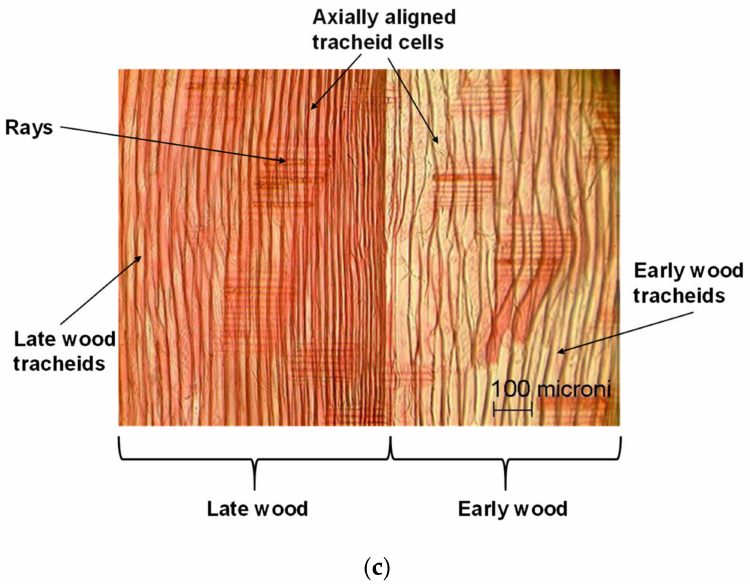
Figure 9. The microscopic view of Scots pine wood: ( a ) Cross section, magnification × 500; ( b ) longitudinal—tangential section, magnification × 100; ( c ) longitudinal—radial section, magnification × 100.